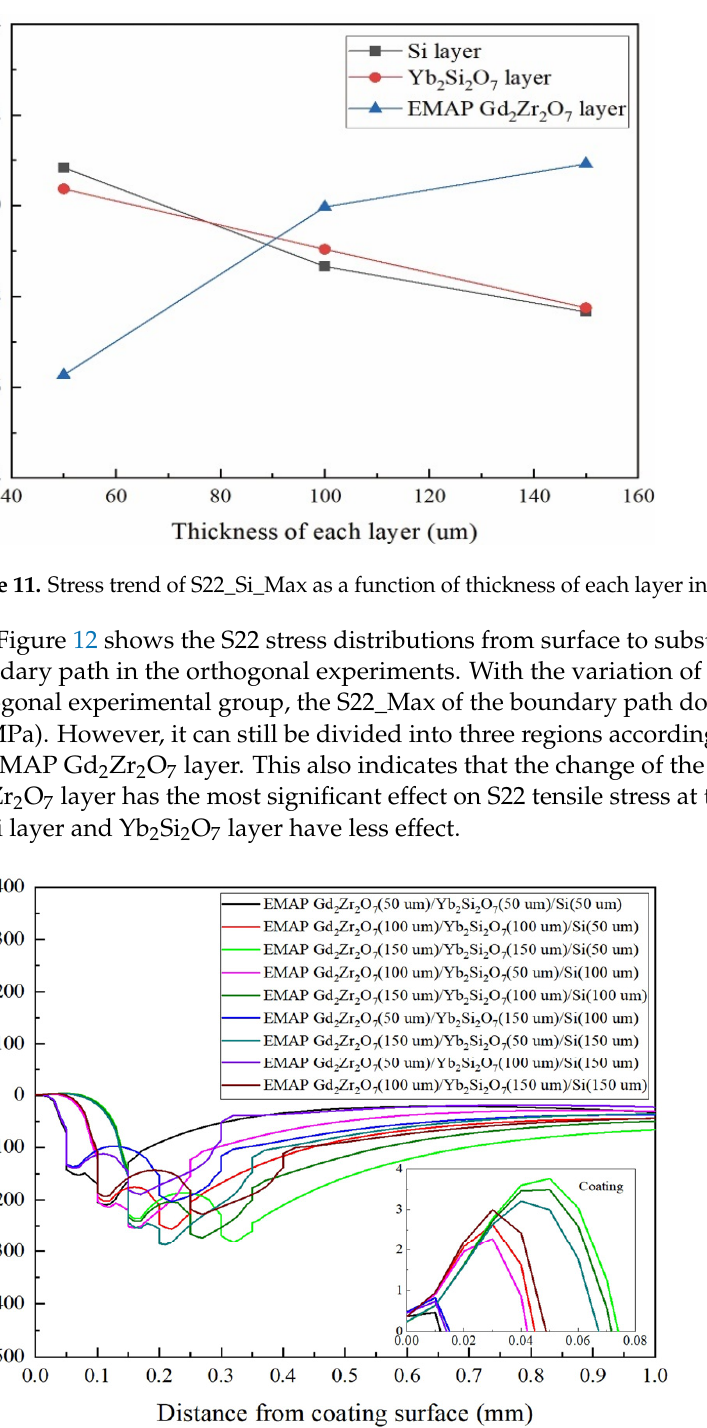
Figure 12. S22 stress distributions from surface to substrate along the right boundary path in the orthogonal experiments.